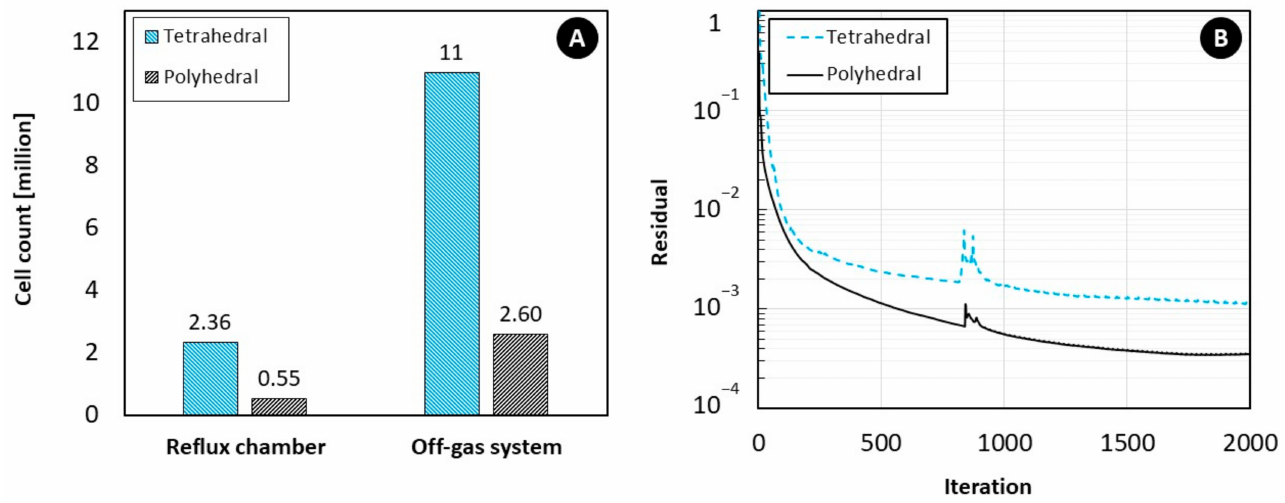
Figure 5. Cell count ( A ) and residuals ( B ) for different cell